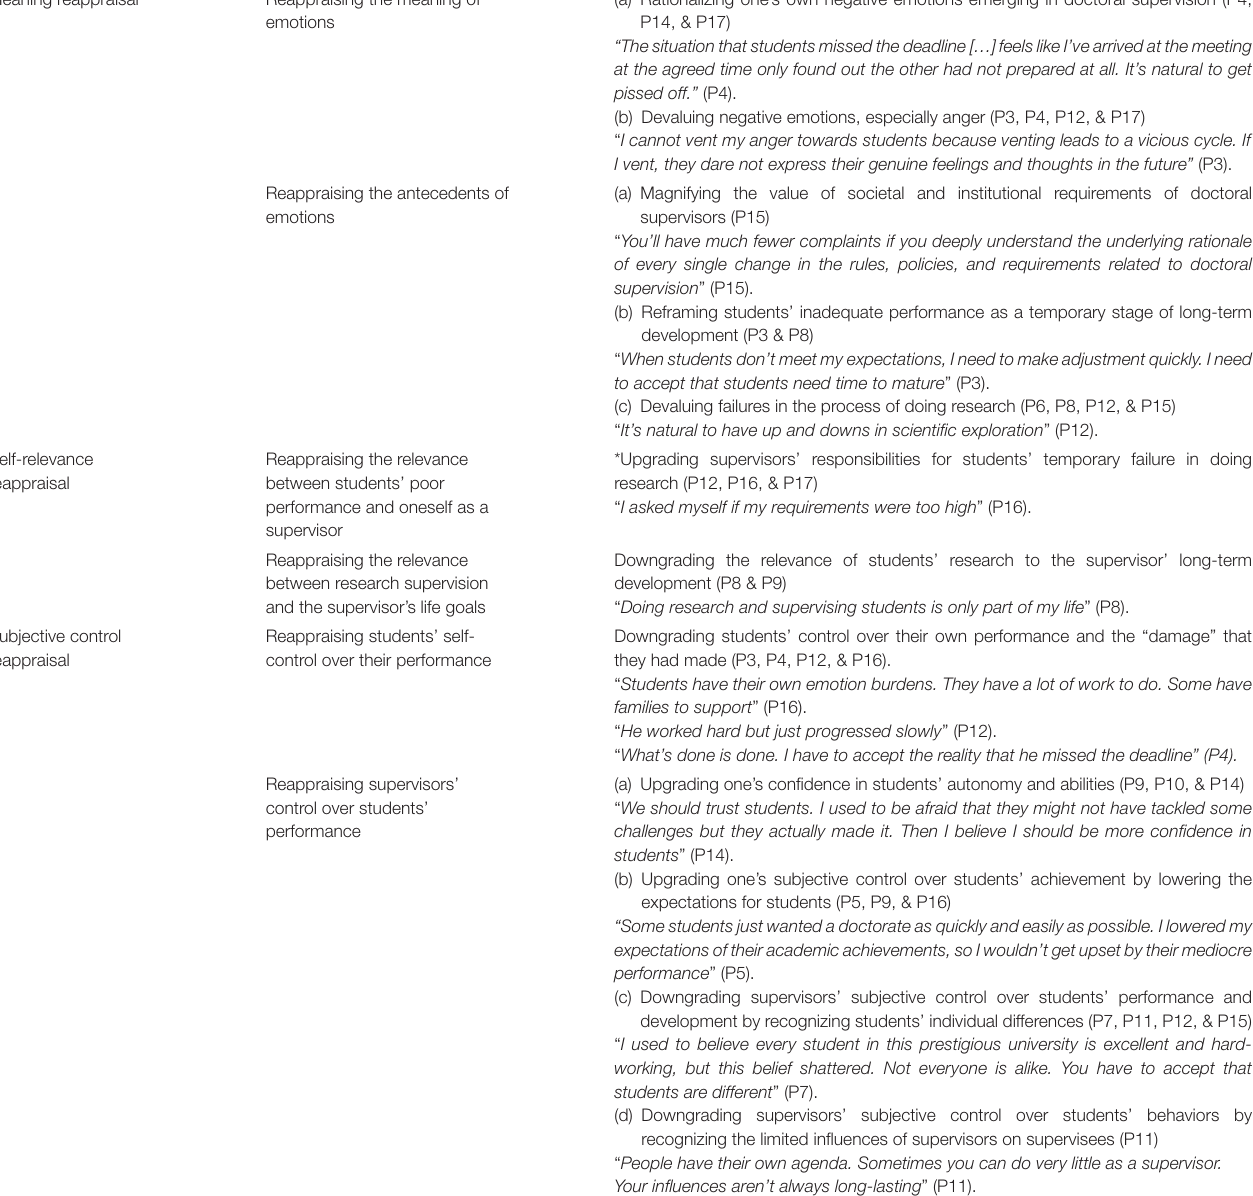
TABLE 5 | Different patterns of cognitive change employed by the